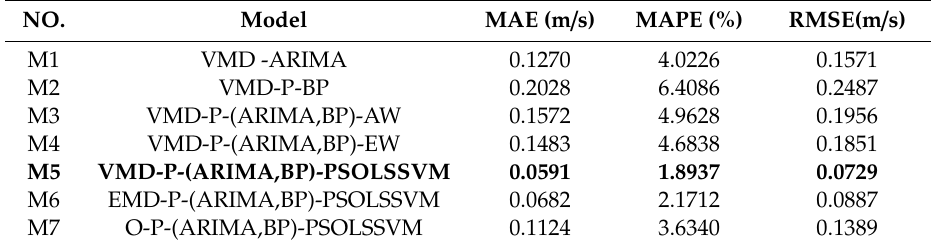
Table 12. Supplementary case prediction results